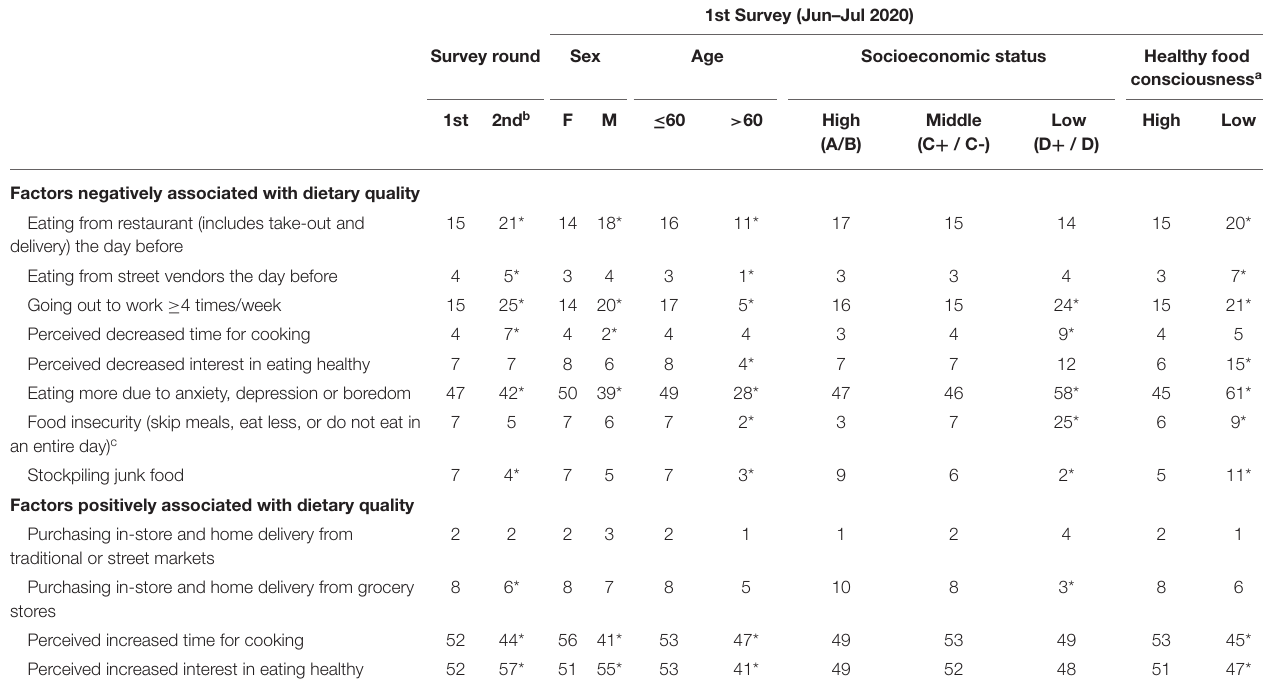
TABLE 3 | Frequency of pandemic related factors negatively and positively associated with dietary quality by survey, sociodemographic, and individual